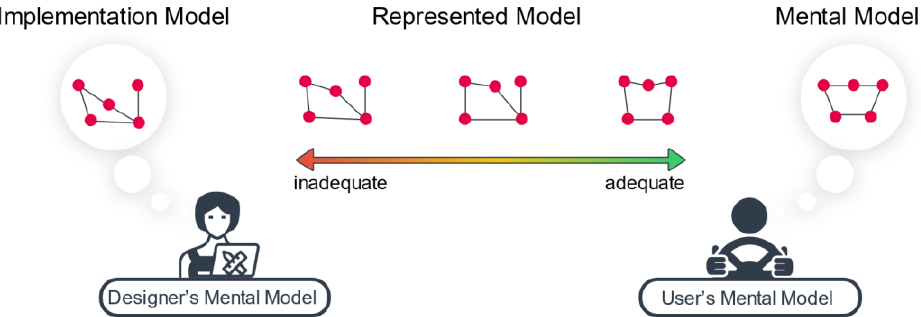
Figure 2. Implementation model representing technological standpoint while the mental model reflects the user’s understanding of the system, based on Cooper et al. [37]. Differences in the mental model of designer and user are indicated by different graphical representations of the system.